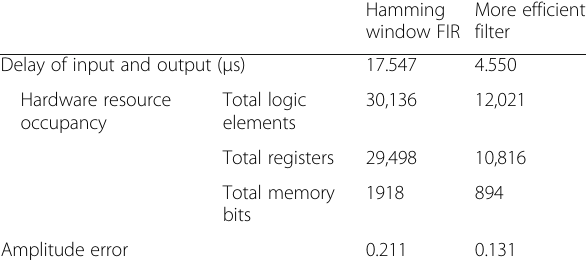
Table 3 Performance comparison of two digital filtering methods in multi-rate design